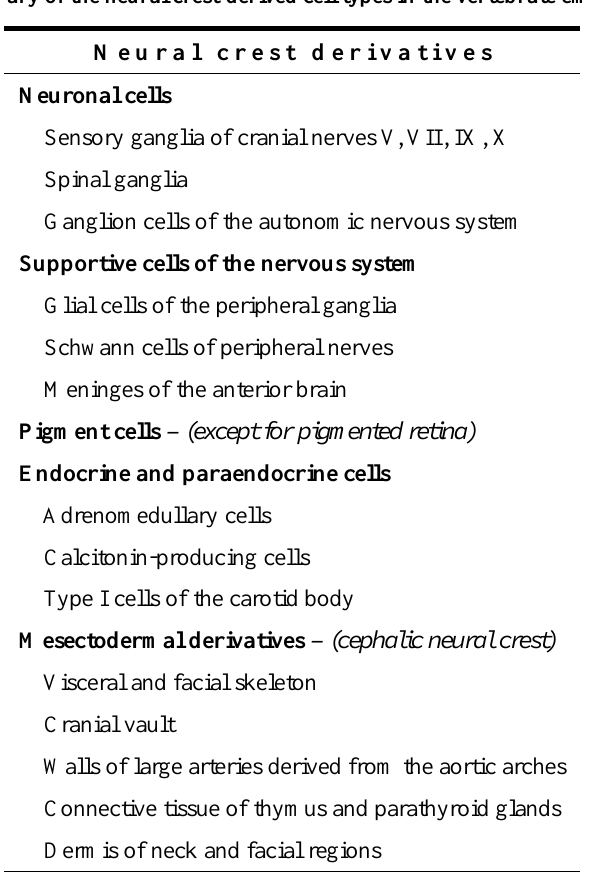
Summary of the neural crest-derived cell types in the vertebrate